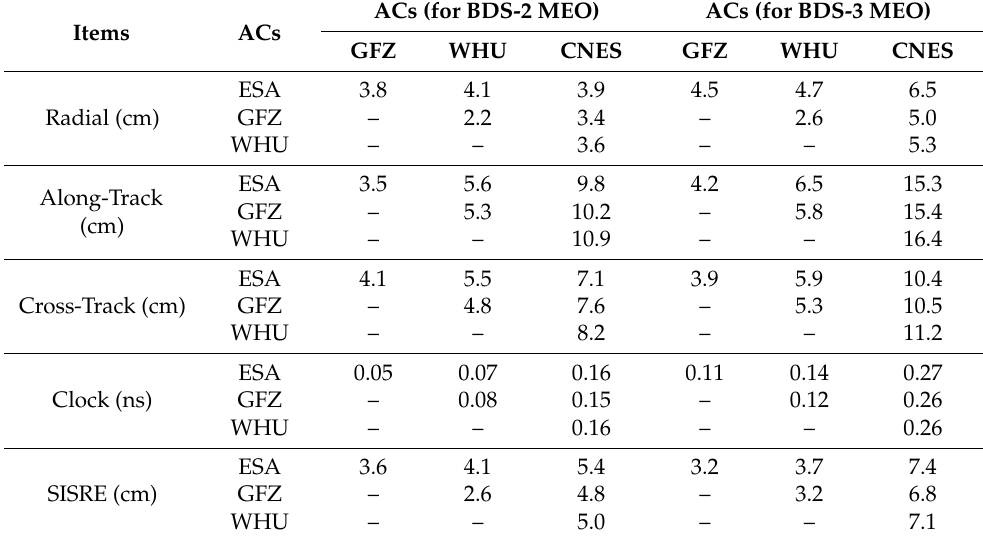
Table 6. RMSs of epoch-wise differences of precise satellite orbit and clock corrections among different ACs as well as SISRE statistics for BDS-2 MEO and BDS-3 MEO satellites. Items